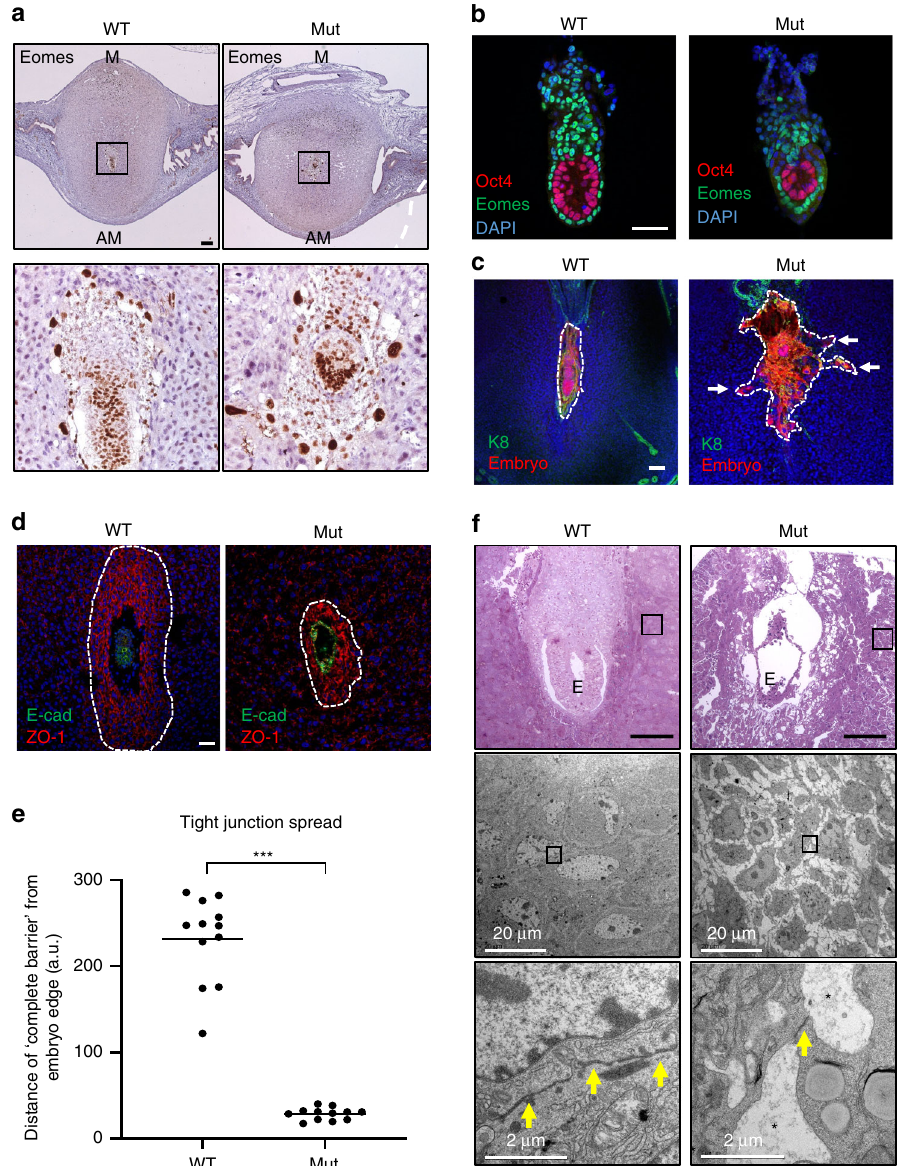
Fig. 3 Loss of the primary decidual zone barrier in Blimp1 mutants. a IHC identi fi es invasion of Eomes positive trophoblasts into the PDZ in Blimp1 mutant decidua ( n = 5 decidua per genotype). b IF staining of Oct4 and Eomes in isolated E5.5 embryos from wild-type and Blimp1 mutant mice counterstained with DAPI. Embryos isolated from Blimp1 mutant deciduae display normal epiblast morphology but distinct disruption of the extraembryonic ectoderm ( n = 5 embryos per genotype). c Immuno fl uorescence staining of RFP (to identify embryonic cells) and K8 (trophoblasts) in wild type; mTmG and Blimp1 mutant; mTmG decidua (E5.5) counterstained with DAPI. White dotted lines outline embryos. White arrows in Blimp1 mutant;mTmG images indicate migrating trophoblast cells. RFP-labelled embryos from Blimp1 mutant; mTmG mice are highly disrupted and invade into the PDZ ( n = 5 per genotype). d IF staining of E-cad (embryo) and ZO-1 in E5.5 mutant and wild-type decidua counterstained with DAPI. Reduced ZO-1 staining indicates impaired tight junction formation in the PDZ of mutants ( n = 5 per genotype). White dotted lines outline the PDZ. e Reduced ZO-1 positive area forming a ‘ complete barrier ’ in the PDZ of E5.5 mutants demonstrates impaired barrier formation. Data from 12 tissue sections from four samples per genotype are shown. Bars represent mean. Two-tailed unpaired Student ’ s t -test *** p = 2.01 × 10 − 12 . Source data are provided as a Source Data fi le. f TEM of E6.5 PDZ con fi rms loss of a complete barrier in mutants ( n = 3 per genotype). Top panel shows sections of resin embedded samples counterstained with toluidine blue for general morphology before TEM was undertaken. Yellow arrows indicate tight junctions at cell – cell borders. Asterisks mark intercellular spaces. E = embryo, M = mesometrial, AM = antimesometrial, a.u. = arbitrary units. Scale bars = 100 μ m unless otherwise